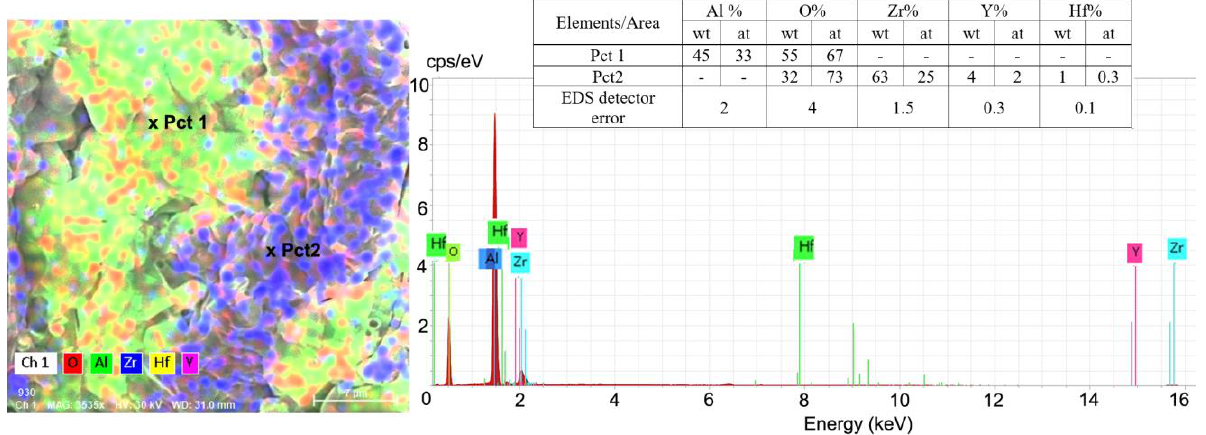
Figure 6. Elemental distribution on transversal ceramic layer and chemical composition in points 1 and 2.